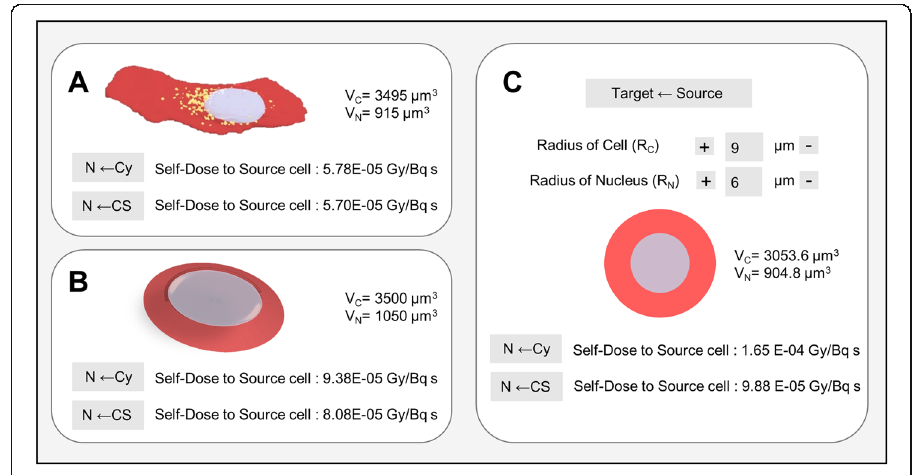
Fig. 5 Effect of accurate shape modeling on the self-dose to the nucleus. a Example of a typical cell morphology with the corresponding S values from cell surface and cytoplasm. The same S values corresponding to the sphere b and truncated cone c when selecting similar volumes are reported for comparison. V